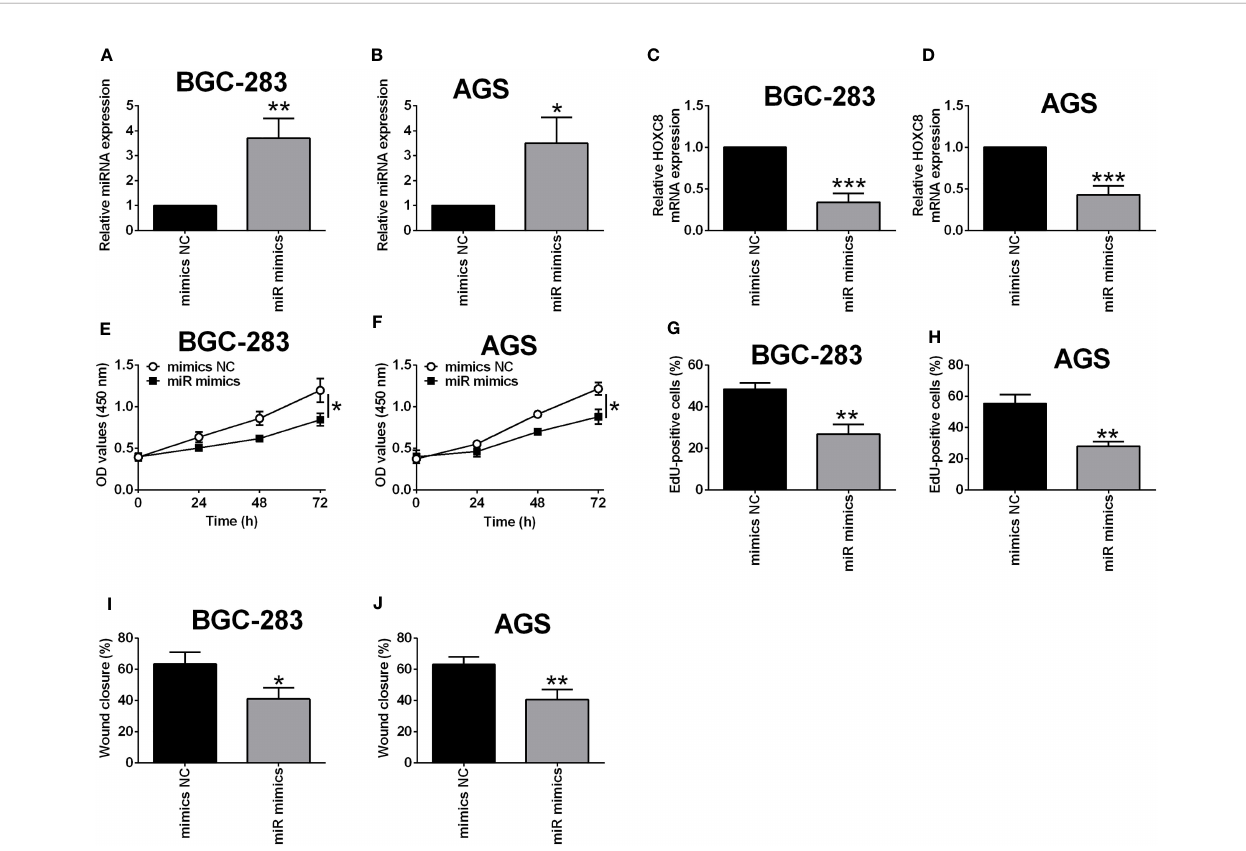
FIGURE 9 | Overexpression of miR-4256 down-regulated HOXC8 expression and suppressed gastric cancer cell proliferation and migration. (A-J) BGC-823 cells and AGS were respectively transfected with HOXC8 siRNAs or the corresponding negative controls, and at 24 h after transfection, the relative expression of miR- 4256 in BGC-823 (A) and AGS (B) cells was determined by qRT-PCR; the relative mRNA expression of HOXC8 in BGC-823 (C) and AGS cells (D) was determined by qRT-PCR; the cell proliferation of BGC-823 (E) and AGS (F) was determined by EdU incorporation assay; the cell viability of BGC-823 (G) and AGS (H) was determined by CCK-8 assay; the cell migration of BGC-823 and AGS; the cell migration of BGC-823 (I) and AGS (J) was determined by wound healing assay. N = 3. *P < 0.05, **P < 0.01 and ***P <